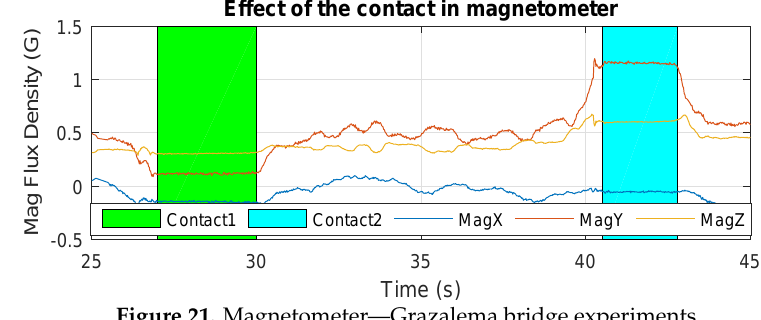
Figure 21. Magnetometer—Grazalema bridge experiments.